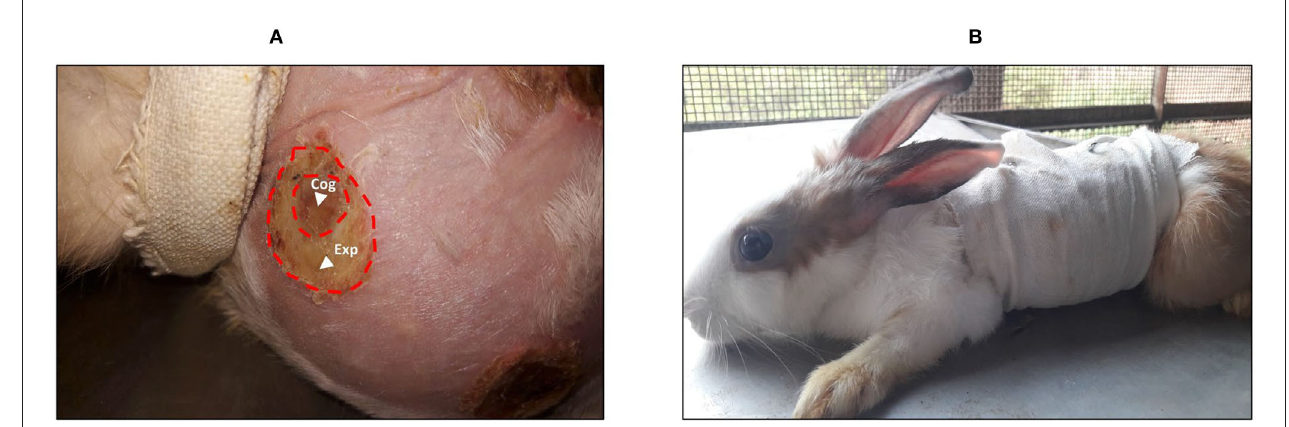
FIGURE 2 | (A) Burn wound with the area of expansion that reveals a white color when compared with the coagulation zone. (B) A rabbit in a bandage after treatment protocol. Cog, coagulation zone; Exp, expansion zone.